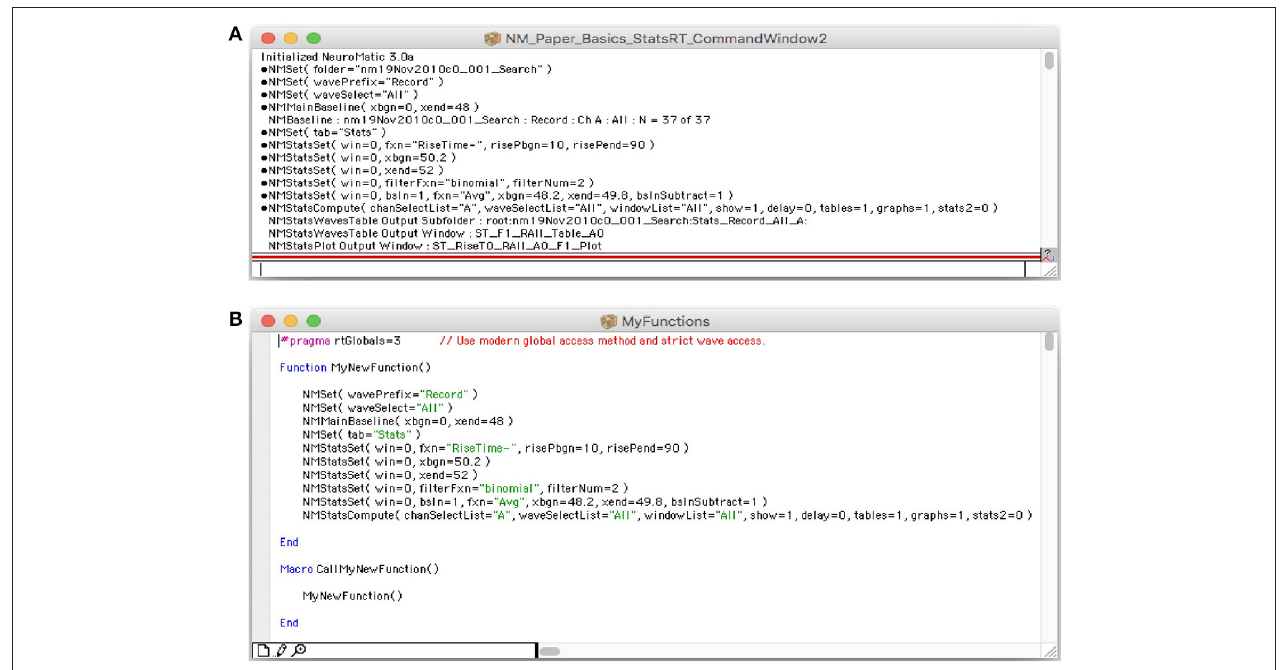
FIGURE 5 | NeuroMatic commands and notes printed to Igor’s Command Window. (A) Screen capture of Igor’s Command Window (Menu/Windows/Command Window), a useful tool that creates a historical log of the researcher’s workflow, from acquisition to analysis and simulation. Both Igor and NeuroMatic print function commands and analysis/transform notes to this window. Function commands are preceded by a small circular bullet. Analysis/transform notes sometimes appear after the function command. NeuroMatic commands can also be printed to an Igor notebook (GUI/Configs/NM/CmdHistory/Notebook). (B) Screen capture of an Igor procedure window (Menu/Windows/New/Procedure…) named “MyFunctions” containing a function called “MyNewFunction.” NeuroMatic function commands were copied from Igor’s Command Window (A) and pasted into this function. A simple macro named “CallMyNewFunction” was created to call MyNewFunction. Macros are automatically listed in Igor’s Macros menu where they can be readily selected and executed. In this way users can create functions of repetitive tasks that need to be performed on multiple data files. Creating such user-defined functions improves research efficiency, documentation and